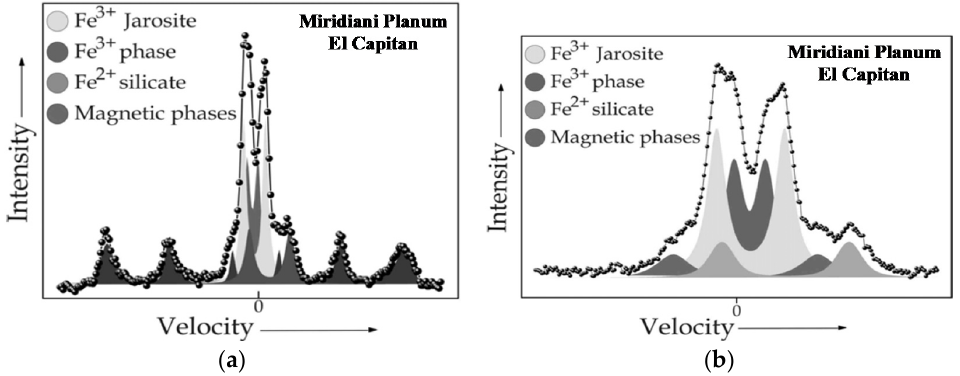
Figure 47. Mössbauer spectra of outcropped target “El Capitan” from Miridiani Planum, Mars measured in the large ve- locity range ( a ) and in the small velocity range ( b ). Adapted from [138].